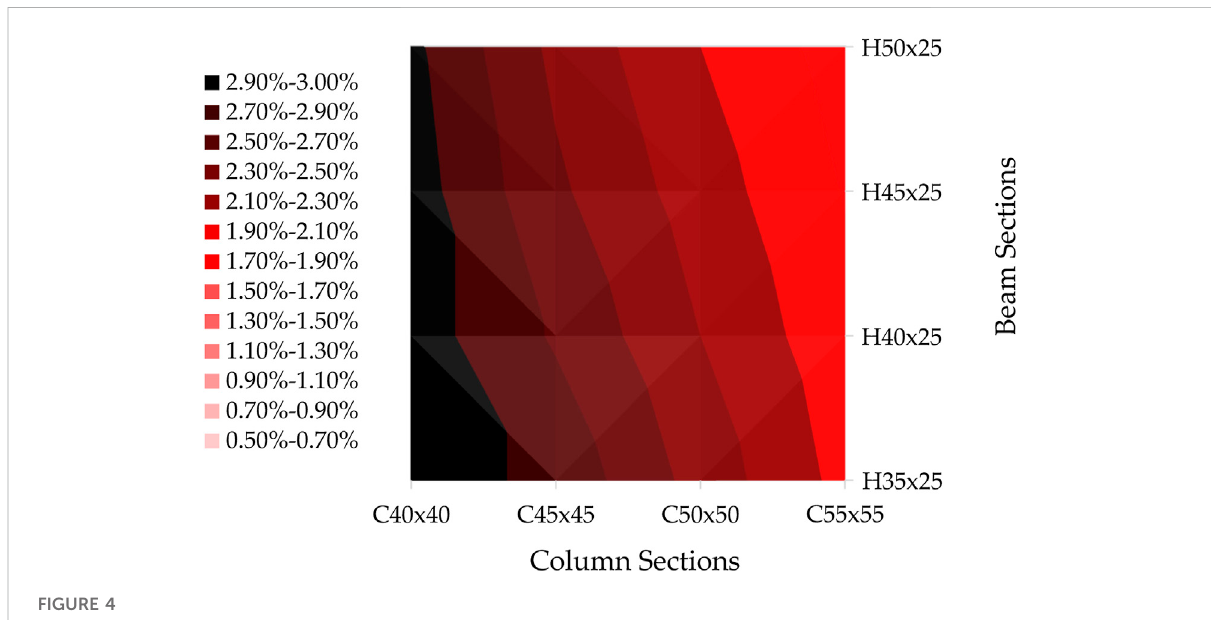
FIGURE 4 Interstory drift results of hidden beam